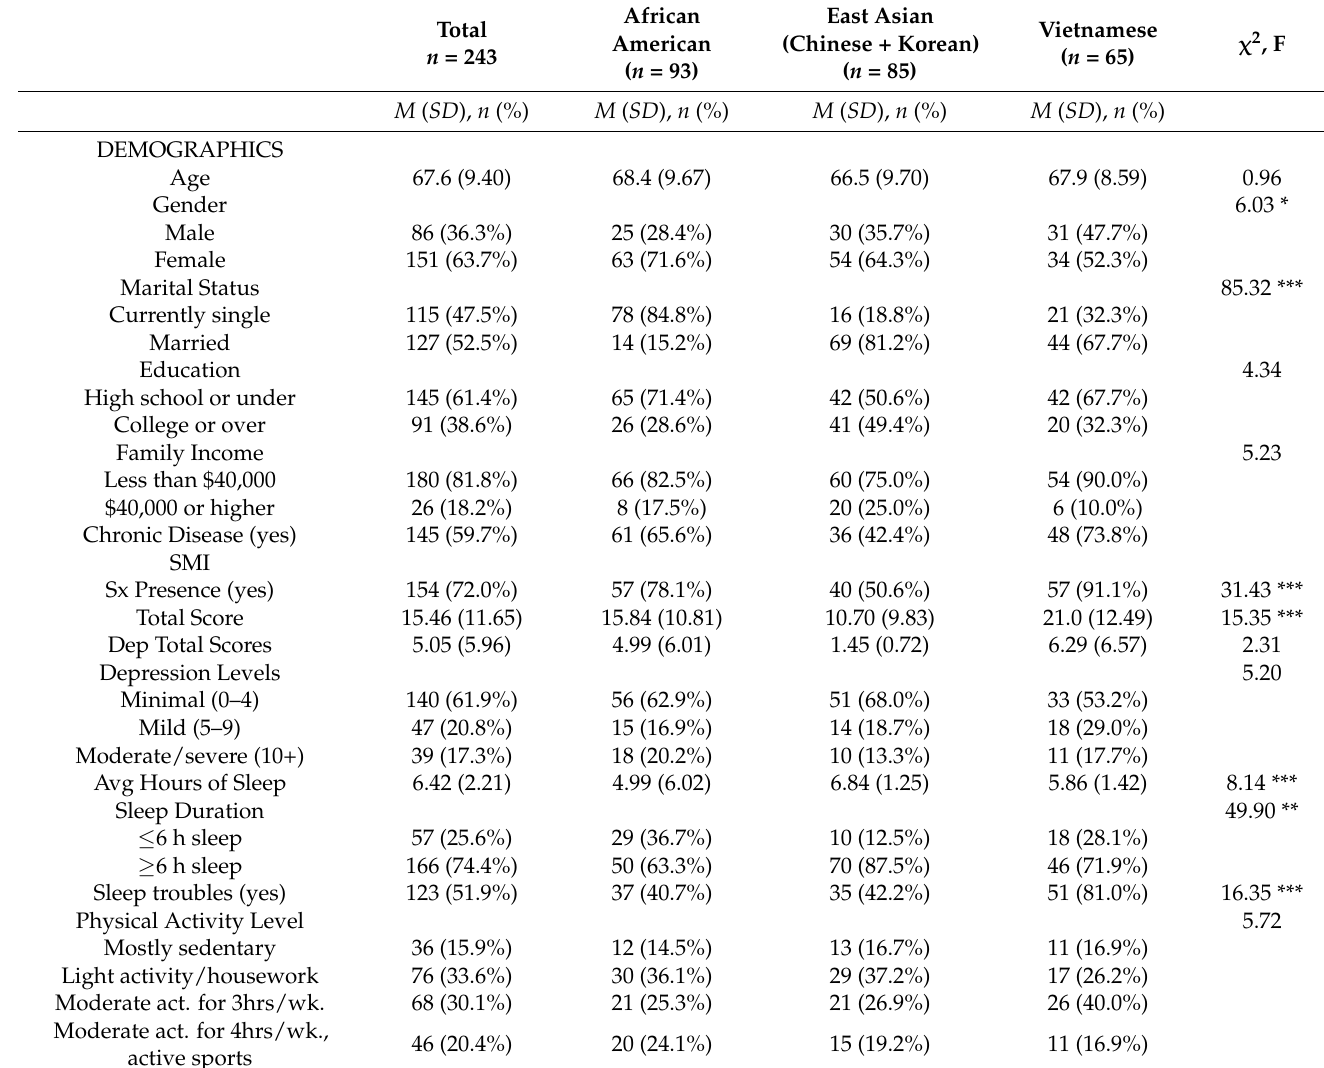
Table 1. Participant Characteristics by Ethnic